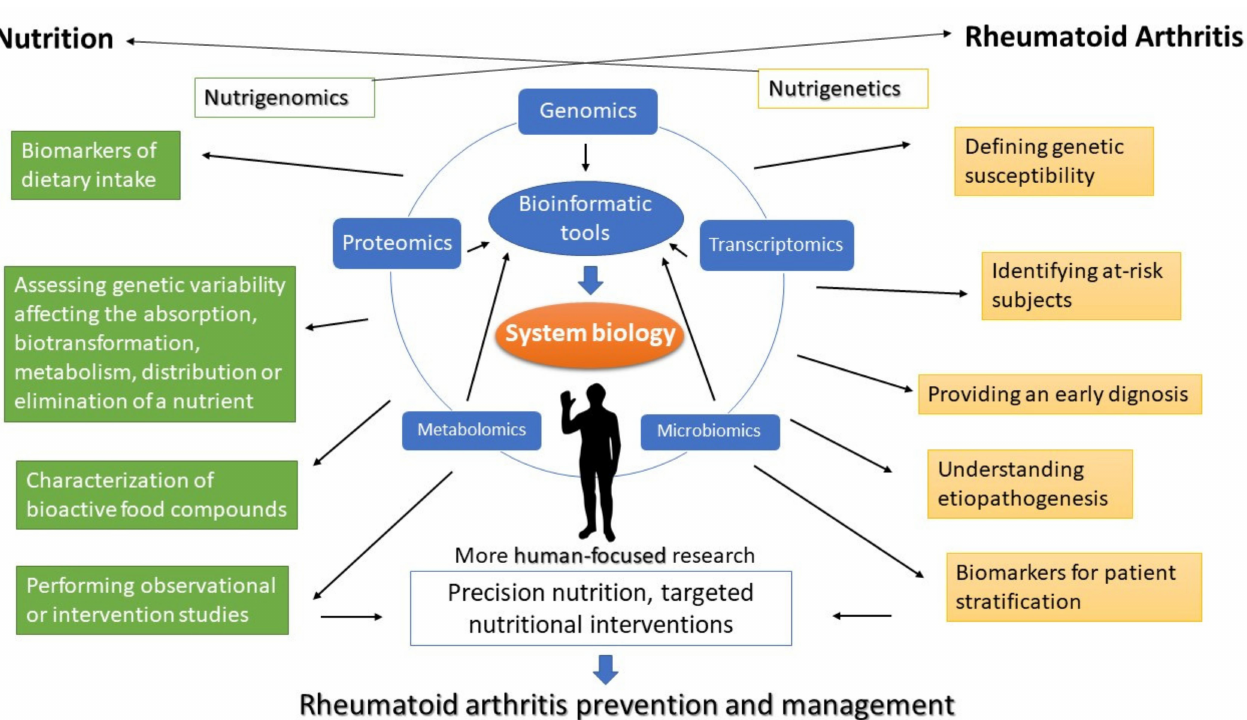
Figure 1. An integrative ‘omics’ approach will lead to a more human-focused research, precision nutrition, eventually resulting in better prevention strategies, as well as better management of rheumatoid